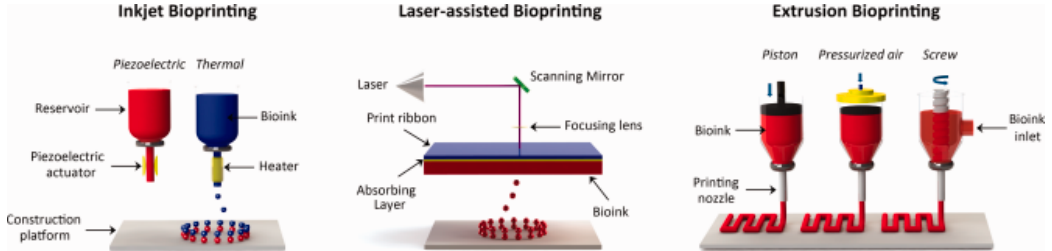
Figure 7. Illustration of 3D bioprinting technologies based on the mechanism used to assist the deposition of the bioinks and its main components; ( Left ) Inkjet bioprinters eject small droplets of cells and hydrogel sequentially to build up the scaffold; ( Middle ) Laser bioprinters use a laser to generate the local ejection of small droplets from a donor ribbon coated with the bioink; ( Right ) Extrusion bioprinters uses pneumatic of mechanical forces to continuously extrude the bioink through a nozzle. Reproduced from [100] with permission. Copyright (2015) Wiley-VCH.